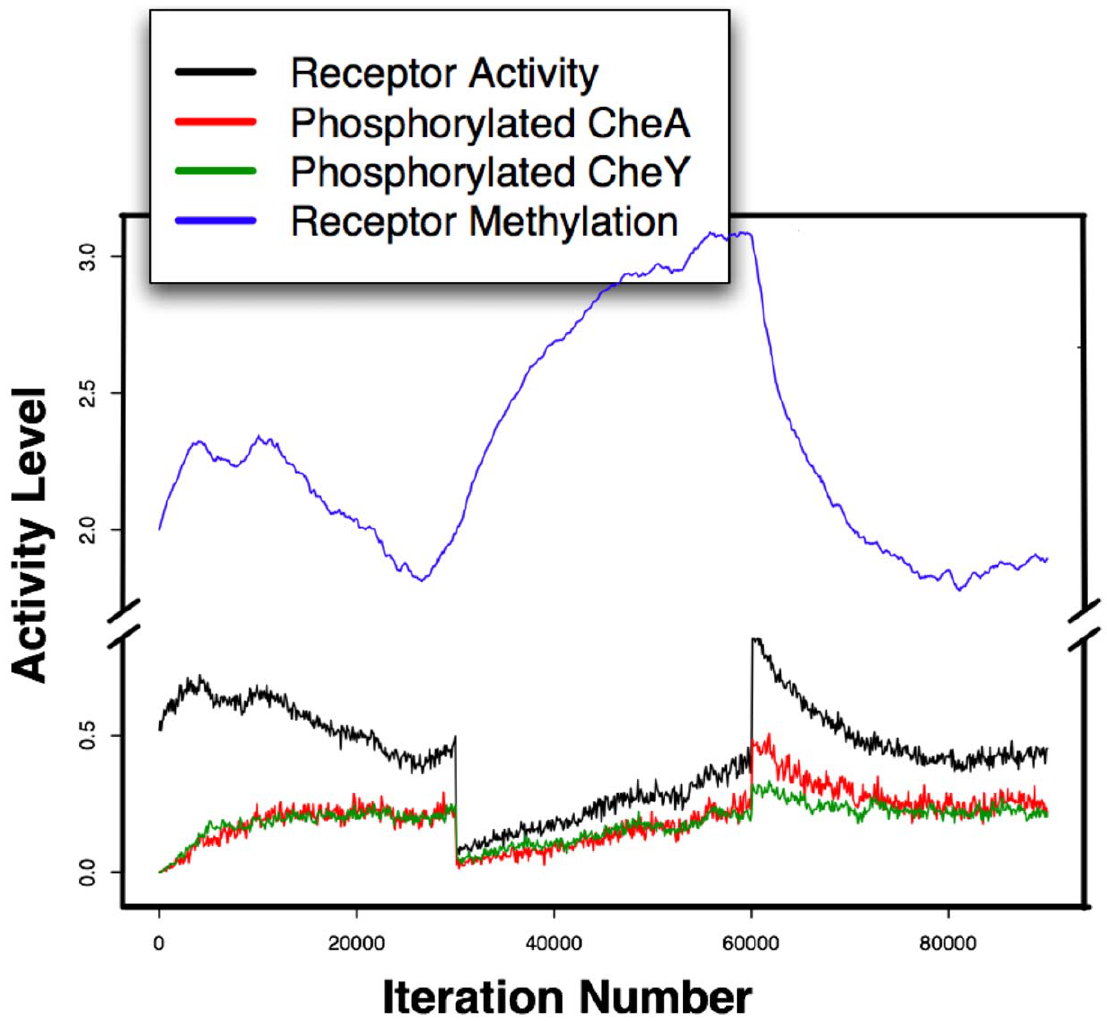
Figure 5. Graph from a single simulation run of a model with a homogeneous Tar receptor population. This model is showing the excitation and adaptation response of fractional receptor activity (black) and average methylation level (blue) in response to the addition and removal of 4 6 10 2 6 M MeAsp at iteration number 30,000 and 60,000, respectively.